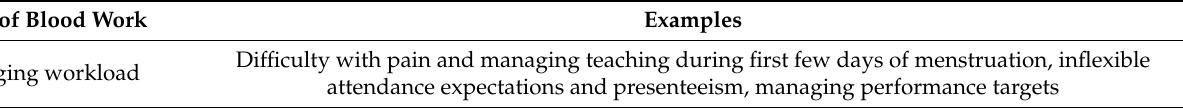
Table 1. Four facets of blood work undertaken by menstruating